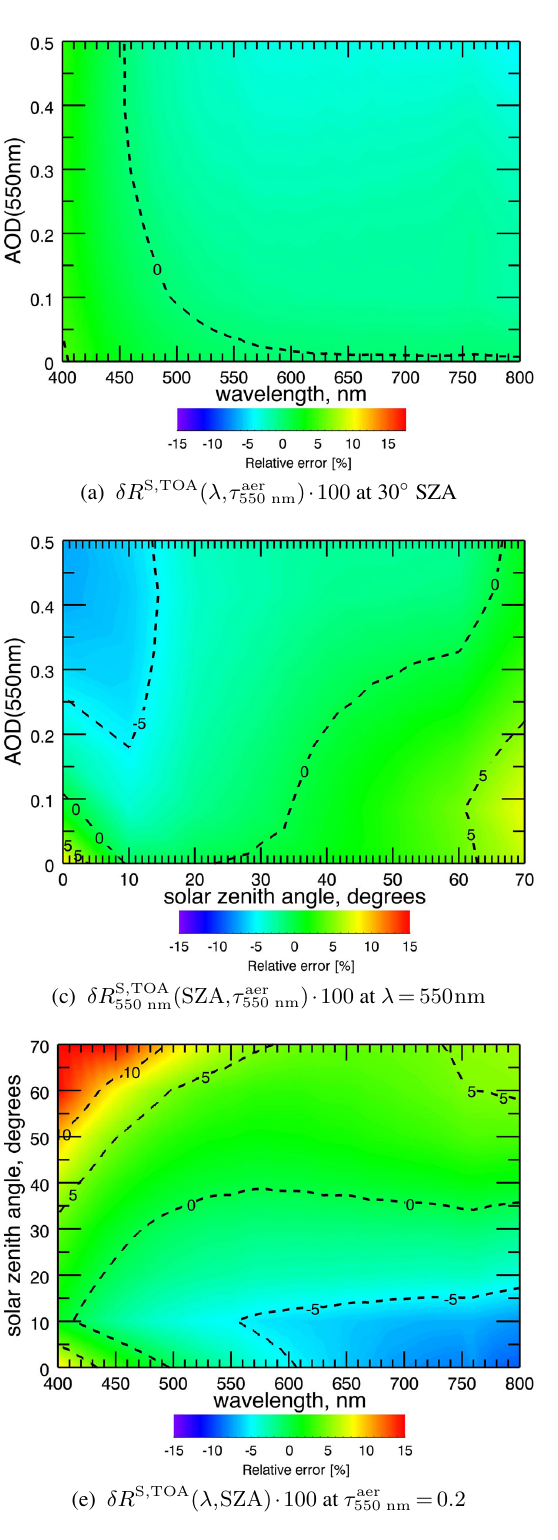
Fig. 7: Overall accuracy with a sensor at top-of-atmosphere. Fig. 7. Overall accuracy with a sensor at